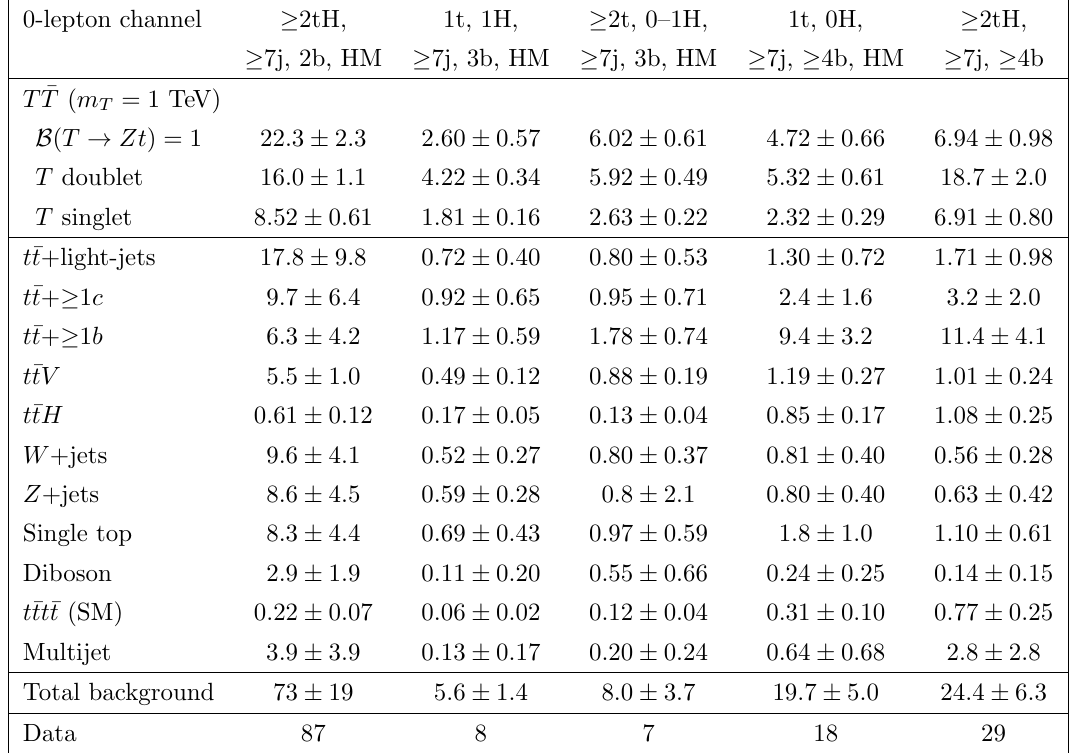
Table 5. Predicted and observed yields in the 0-lepton channel in (cid:12)ve of the most sensitive search regions (depending on the signal scenario) considered. The background prediction is shown before the (cid:12)t to data. Also shown are the signal predictions for di(cid:11)erent benchmark scenarios considered. The quoted uncertainties are the sum in quadrature of statistical and systematic uncertainties in